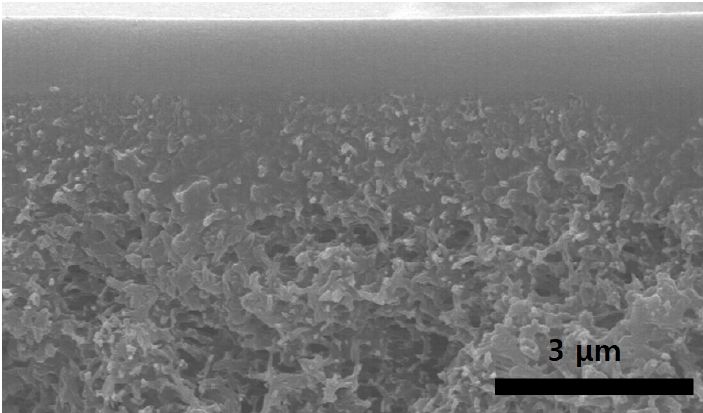
Figure 1. SEM image of poly(ethylene- co -propylene) (EPR)/Ag metal/ p -benzoquinone ( p -BQ)/SiO 2 composite membranes coated onto polysulfone.